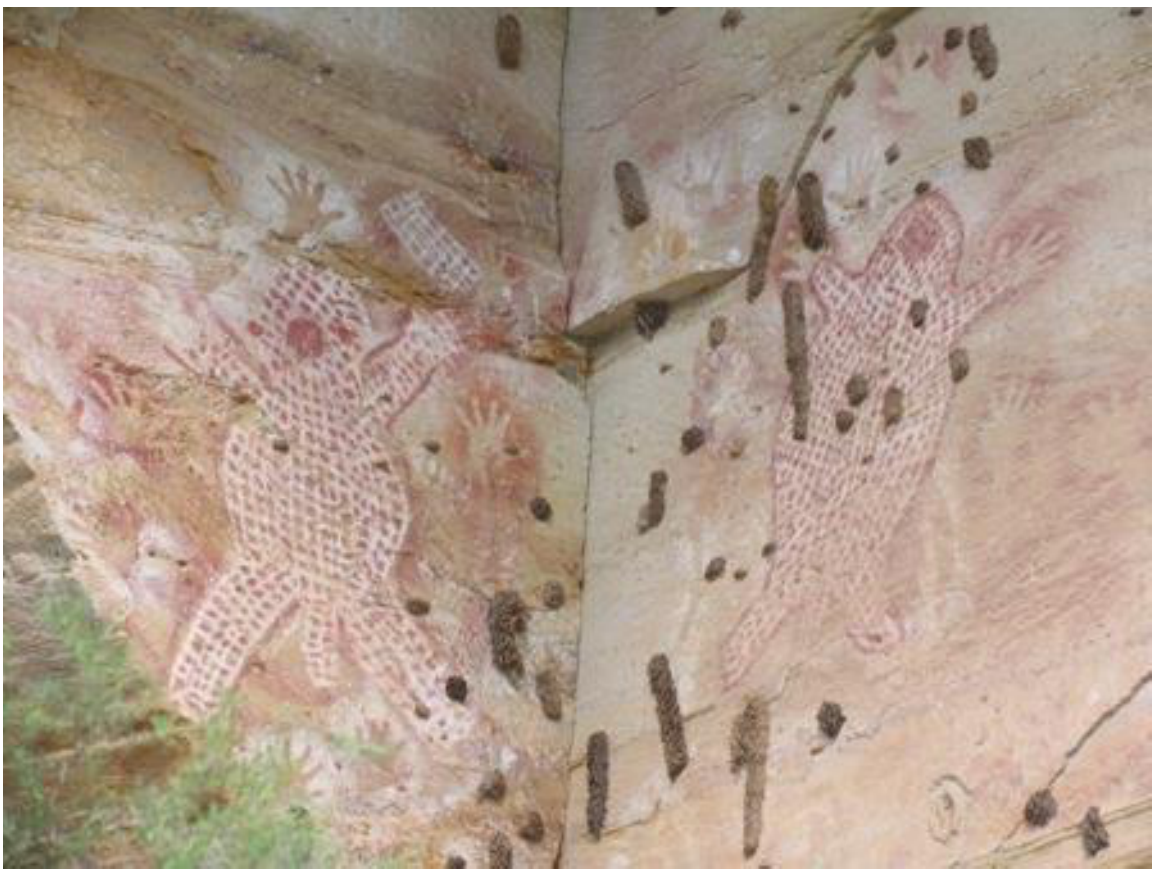
Figure 26. Anthropomorphs with stenciled hands, central Queensland, Australia. Courtesy C.